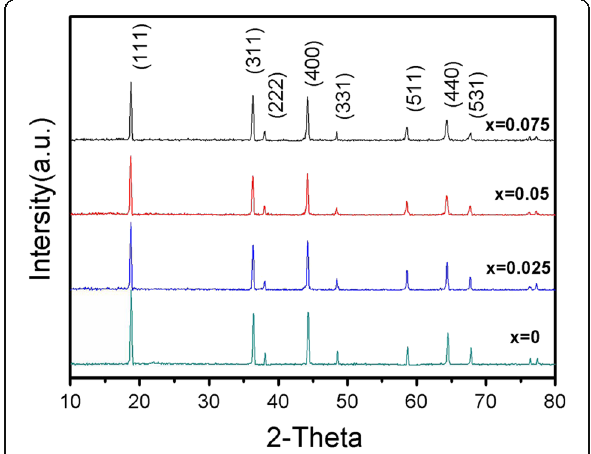
Fig. 1 XRD patterns of LiNi 0.5 Mn 1.5 O 4 and LiCr x Ni 0.5 − 0.5x Mn